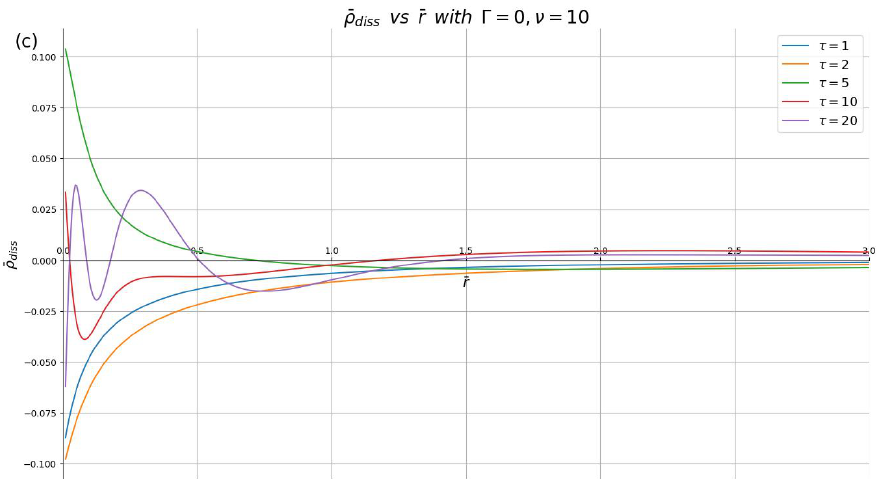
Figure 4. Dissipative part of the induced charge density, ¯ ρ diss , shown in reduced units against the dimensionless radial distance ¯ r for different dimensionless times ( τ = 1,2,5,10,20), with the damping parameter Γ = 0 and the reduced speeds: ( a ) ν = 1, ( b ) ν = 2 and ( c ) ν = 10. In Figure 5, we show ¯ φ diss ( ¯ r , 0, τ ) using the same parameters as in Figure 4. At the times τ (cid:46) 5, the potential ¯ φ diss exhibits a single extremum at a distance close to the origin, with a change of sign similar to that in the charge density ¯ ρ diss , whereas at the time points τ = 10 and τ = 20, there are one and two well-developed wave crests in the potential ¯ φ diss , respectively, which are located at larger radial distances than the corresponding crests in the density ¯ ρ diss . The overall magnitude of ¯ φ diss ( ¯ r , 0, τ ) decreases with increasing speed, but there is no simple scaling as in the case of the charge density. However, the overall shape of the curves ¯ φ diss ( ¯ r , 0, τ ) at different time points is preserved, with some modifications, as the speed increases.